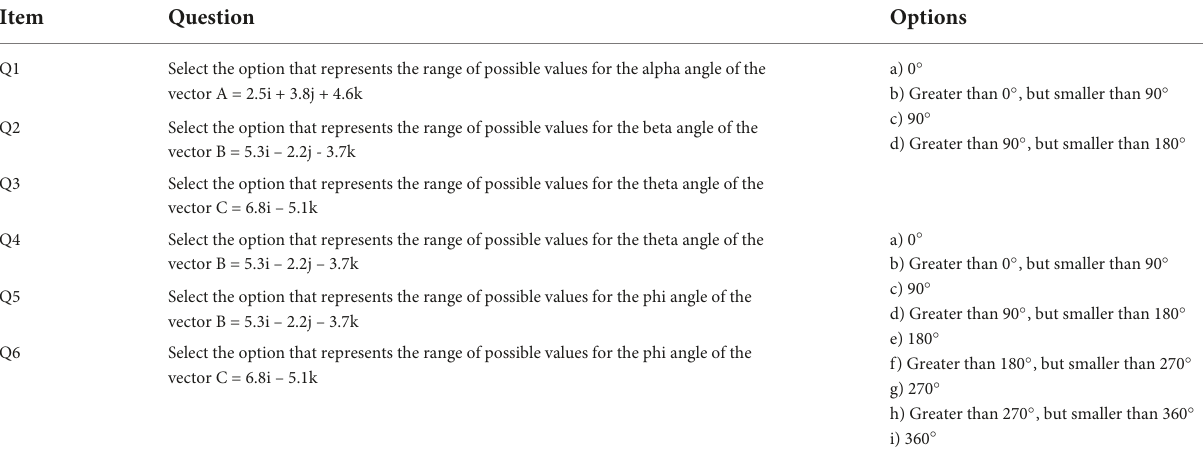
TABLE 1 Six items of the pre-post questionnaire with the objective of analyzing the angles alpha, beta, theta and phi of different